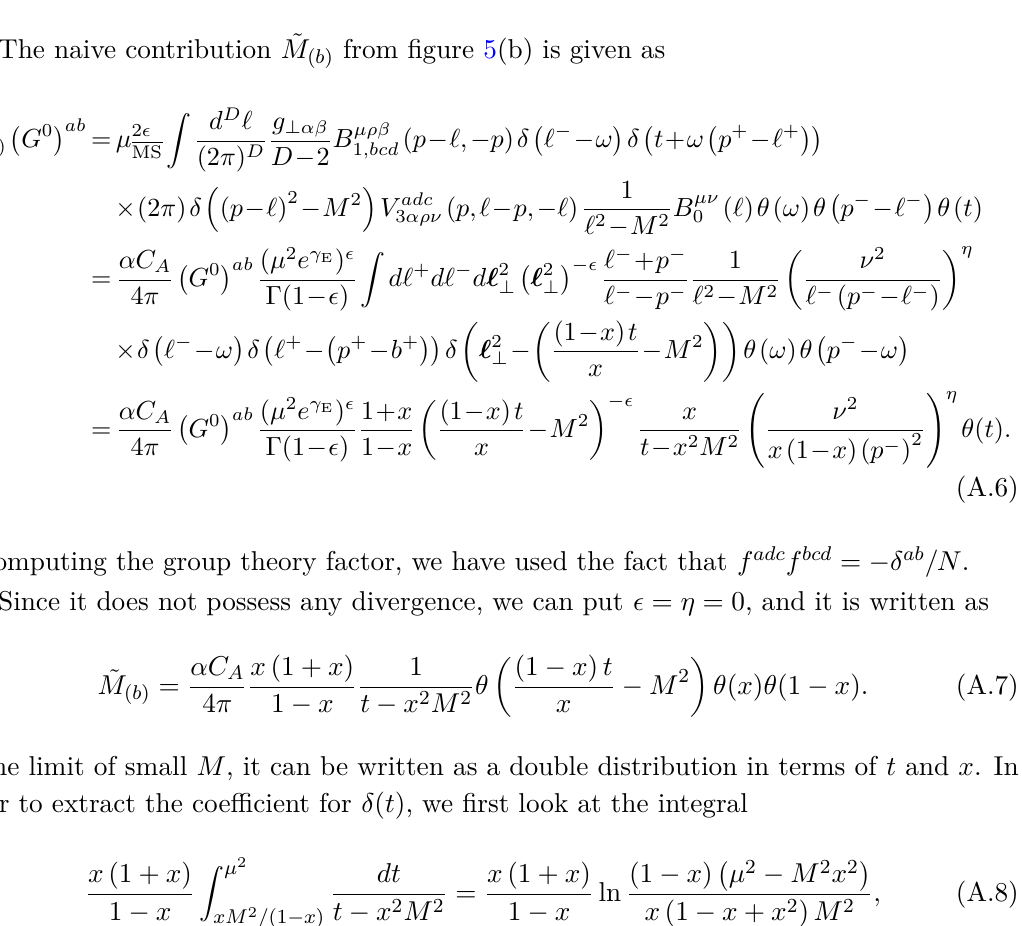
Figure 5 . Feynman diagrams for the beam functions and the PDFs. The wavy lines with solid lines denote collinear gauge bosons, and the solid lines are leptons. The mirror images of (b), (d) and (e) are omitted. For the beam functions, the virtuality t and the longitudinal momentum fraction z are measured, but only z is measured for the